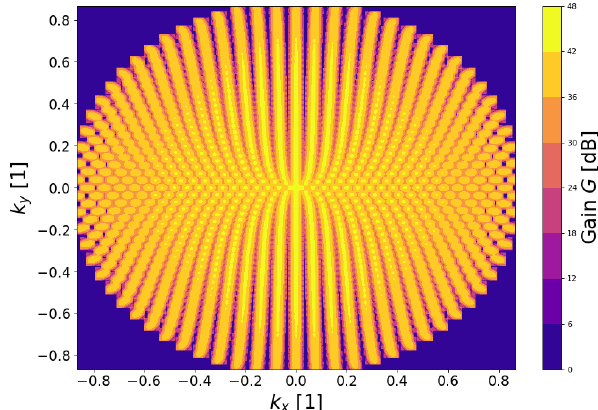
Figure 3. An example full FOV radar scan pattern for E3D includ- ing the beam broadening effect. The coordinate axis are the nor- malised wave vector ground projection k x ,k y . This scan pattern use approximately 1250 scan direction of 0.2s each, completing in about 4–5min.